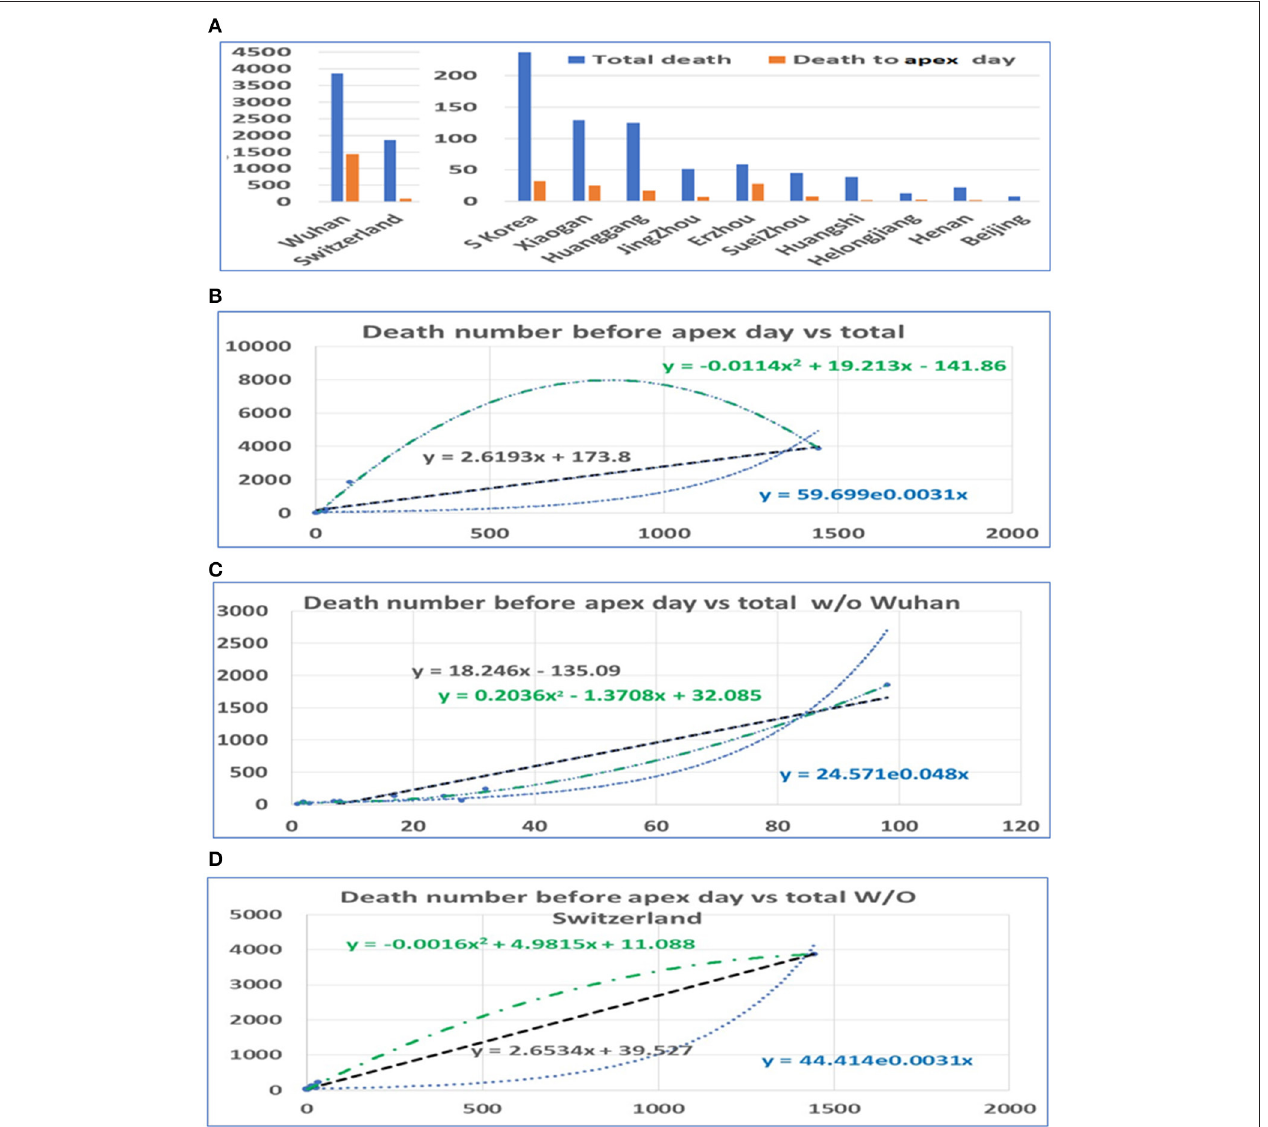
FIGURE 3 | The distribution of mortality before and after the pandemic apex. (A) The mortality in major cities in Hubei Province in China, the provinces with the highest incidence, those in Switzerland, and those in South Korea before and after the apex of the pandemic. (B) The relationship between the total mortality and the mortality before the apex of the disease. The number on the vertical axis is the total mortality, and the horizontal axis is the mortality before the apex of the pandemic. (C) The relationship between the total mortality and the mortality before the apex period, excluding data from Wuhan. (D) The relationship between the total mortality and the mortality before the apex period, excluding data from